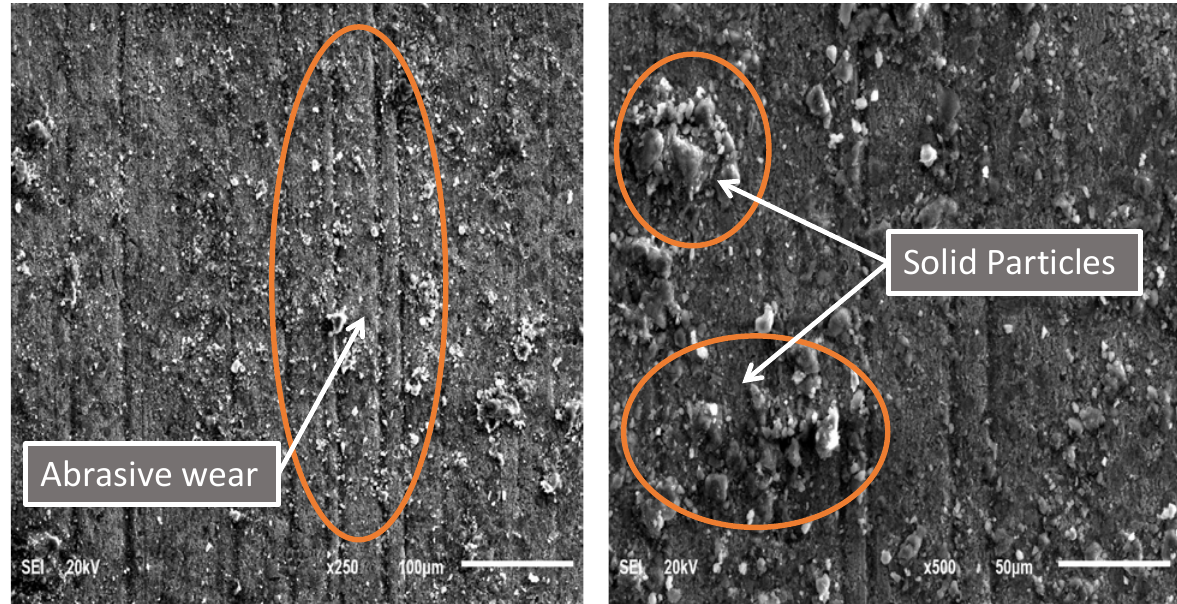
Figure 11. SEM images of the P110 worn casing sample (S3) tested under wet conditions (oil-based drilling fluid) at 207 rpm and 1400 N.